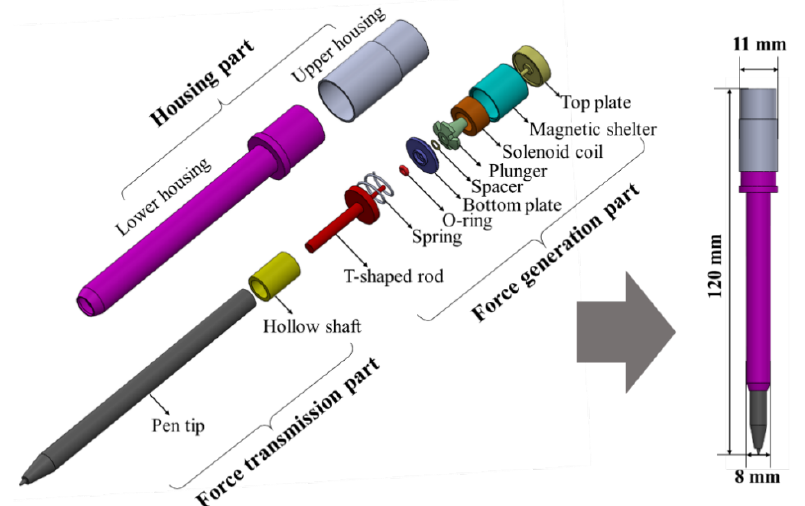
Figure 1. Schematic of the proposed kinesthetic stylus.